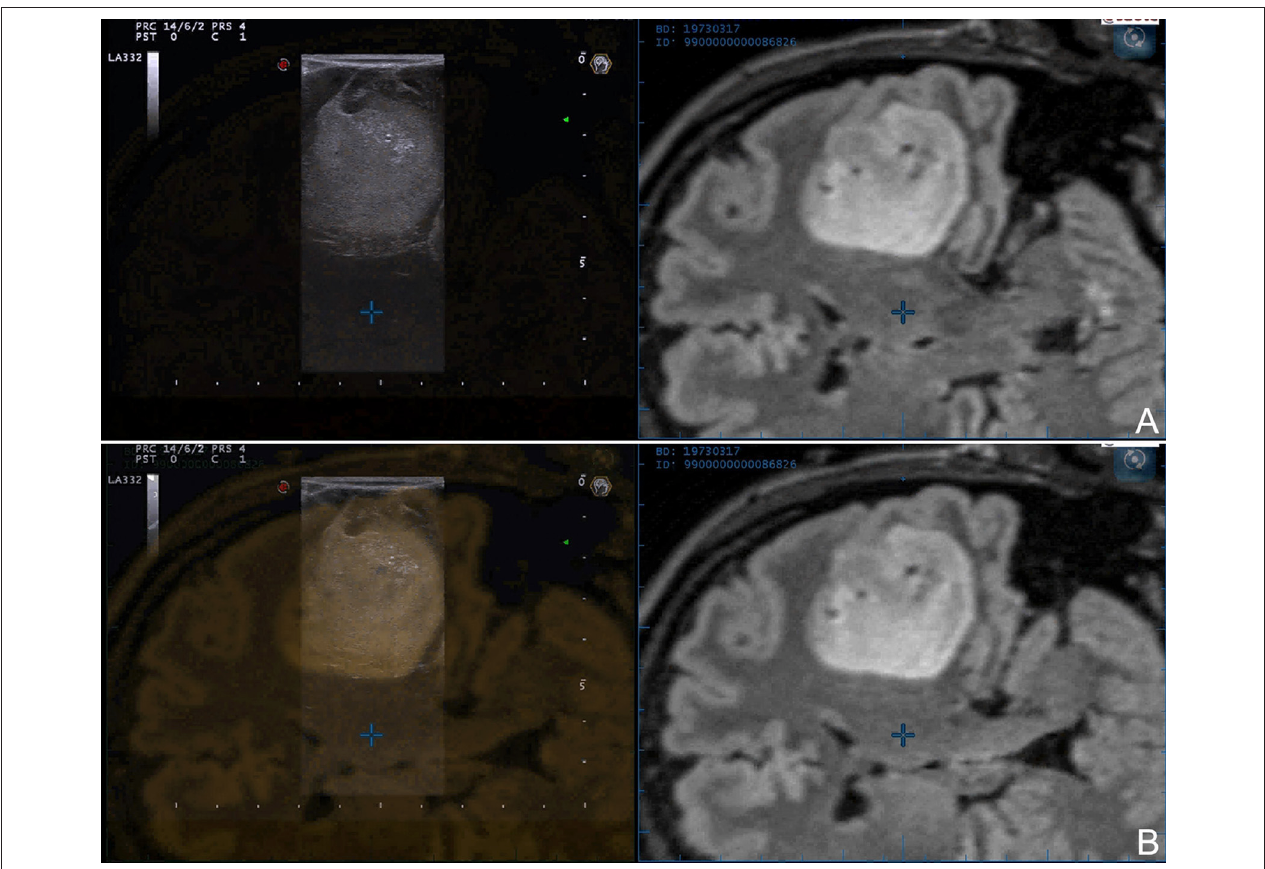
FIGURE 2 | Navigated intra-operative B-mode US in a case of left temporo-insular low-grade glioma. Two different configurations of navigated ioUS are displayed: (A) side-by-side or (B) superimposition. The continuous comparison between the two modalities aid in orientation and understanding of ioUS images.